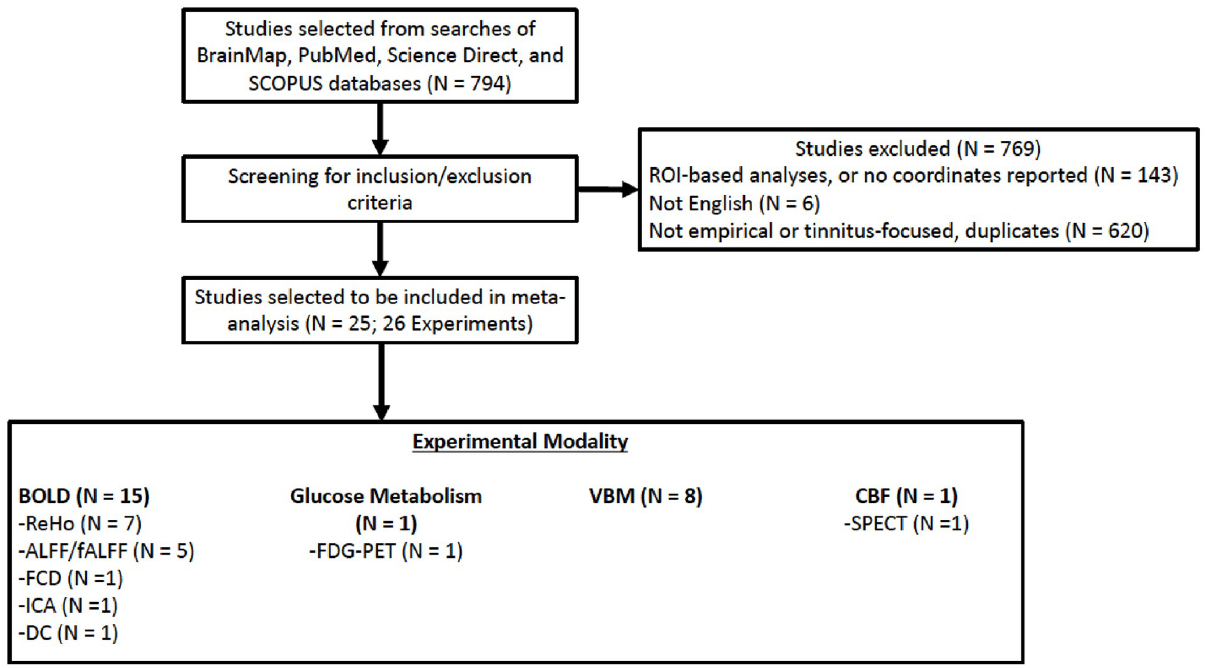
Fig 1. Consort chart of study selection of tinnitus neuroimaging studies. ALFF/fALFF = amplitude of low-frequency fluctuations (ALFF) and fractional ALFF; BOLD = blood oxygen level dependent; DC = degree centrality; FCD = functional connectivity density; FDG-PET = fluorodeoxyglucose PET; ICA = indenpendent components analysis; PET = positron emission tomography; ReHo = Regional homogeneity; SPECT = single-photon emission computed tomography; VBM = voxel-based morphometry.